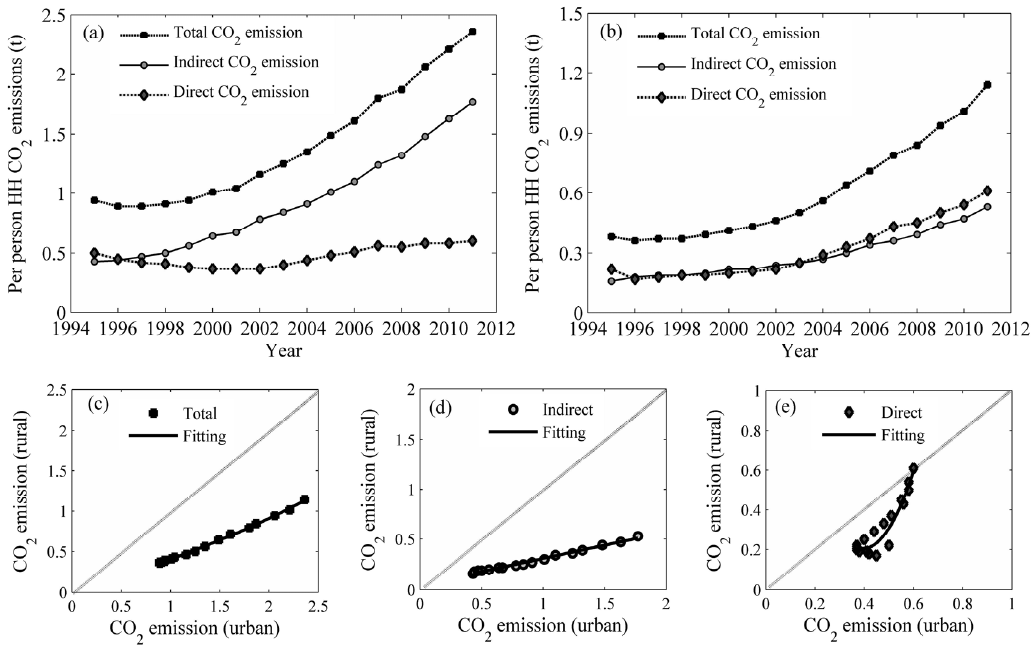
Figure 1. Per person HCEs (tCO 2 /year) from urban and rural people in China: ( a ) urban; ( b ) rural; and ( c – e ): scatter plots of per person HCEs (tCO 2 /year), rural vs.